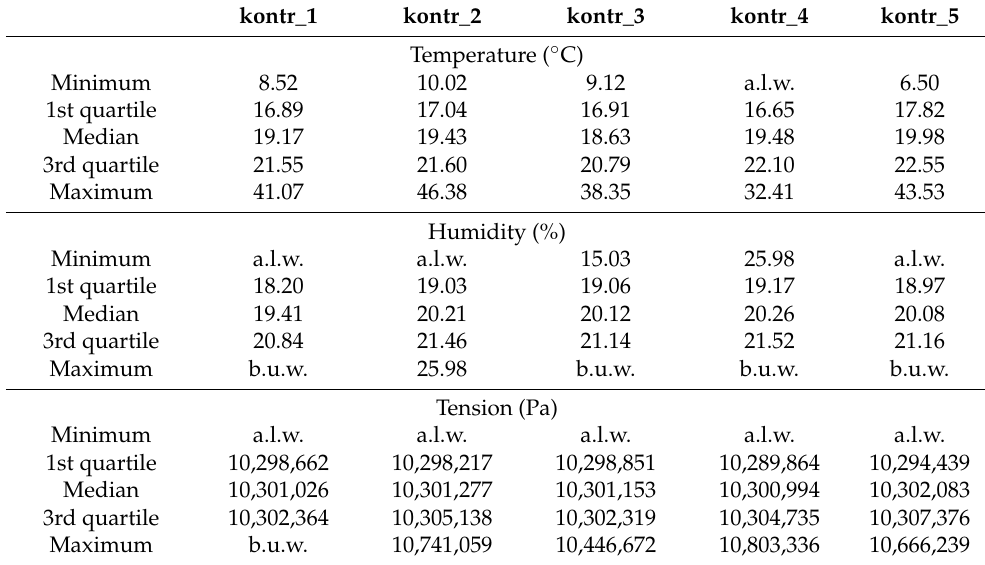
b.u.w.—below upper whisker boundary of the box plot; a.l.w.—above lower whisker boundary of the box plot.